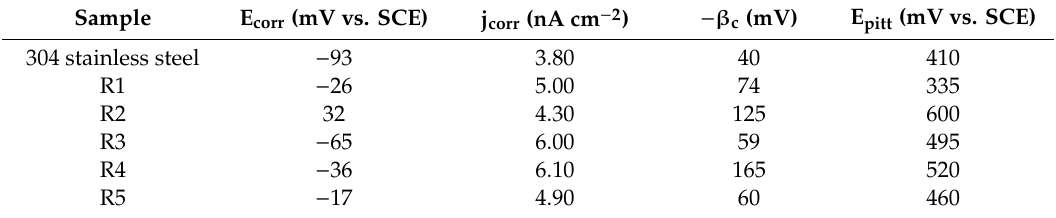
Table 5. Corrosion potentials (E corr ), corrosion current densities (j corr ), slopes of cathodic ( β c ) polarization curves and pitting potentials (E pitt ) values for bare 304 stainless steel and samples